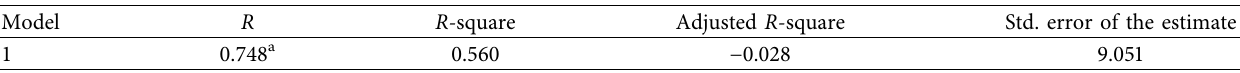
Table 9: Regression values for predictor.